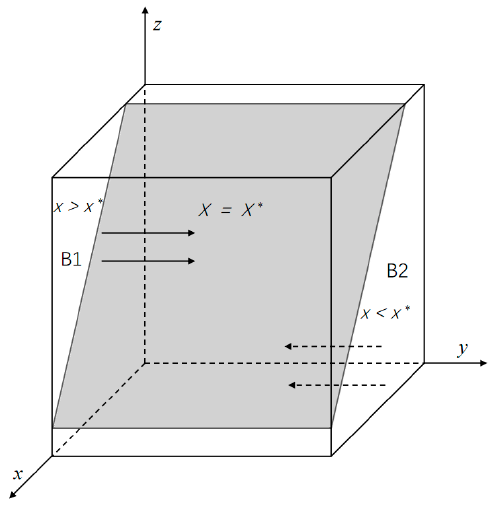
Figure 3. Phase diagram for strategy evolution of the construction service provider.